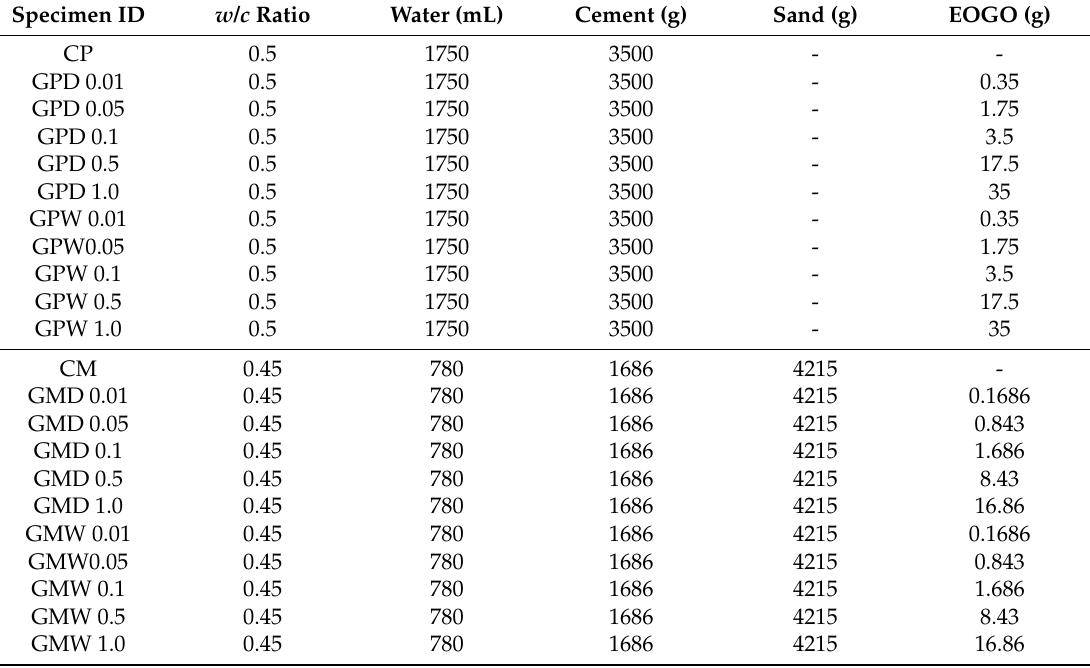
Table 3. Cement paste and mortar mix proportion (see above for definition of